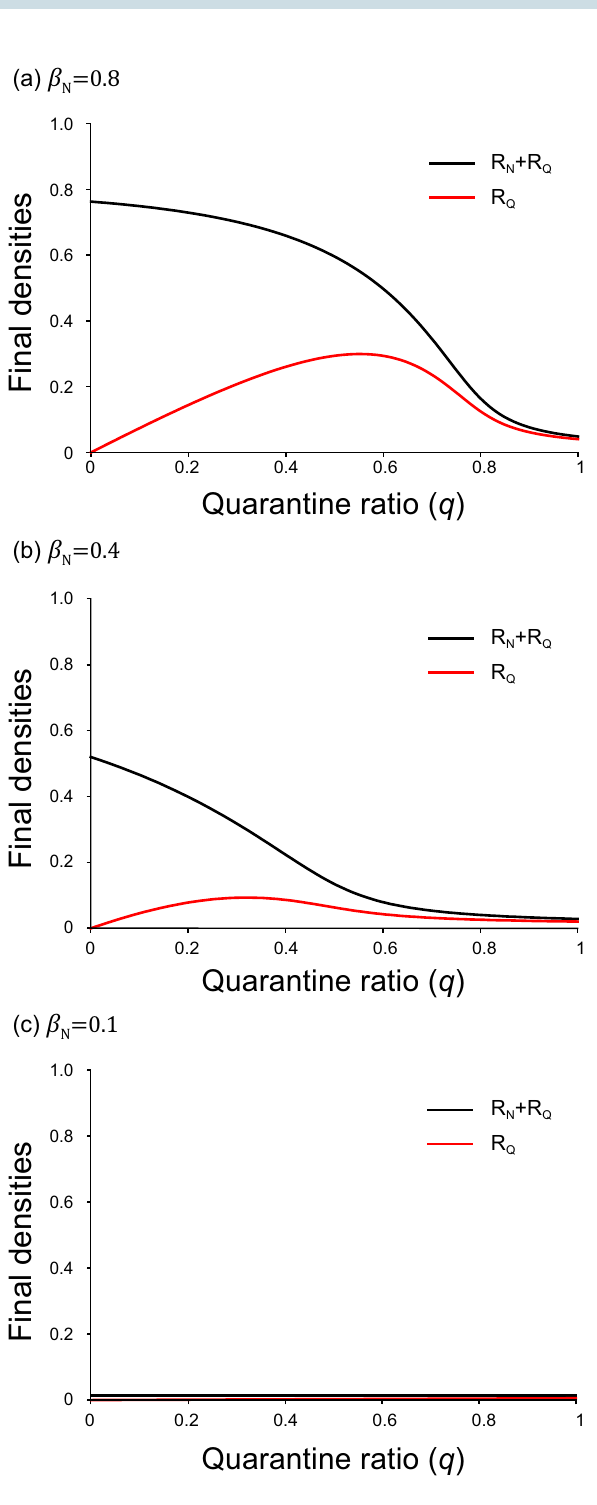
Figure 2. Results of final densities for MFT. The total infection [ R N ( ∞ ) + R Q ( ∞ ) ] and apparent infection [ R Q ( ∞ ) ] are plotted against quarantine ratio ( q ). We fix γ N = γ Q = 0.2 , β Q = 0.1 . ( a ) β N = 0.8 , ( b ) β N = 0.4 and ( c ) β N = 0.1